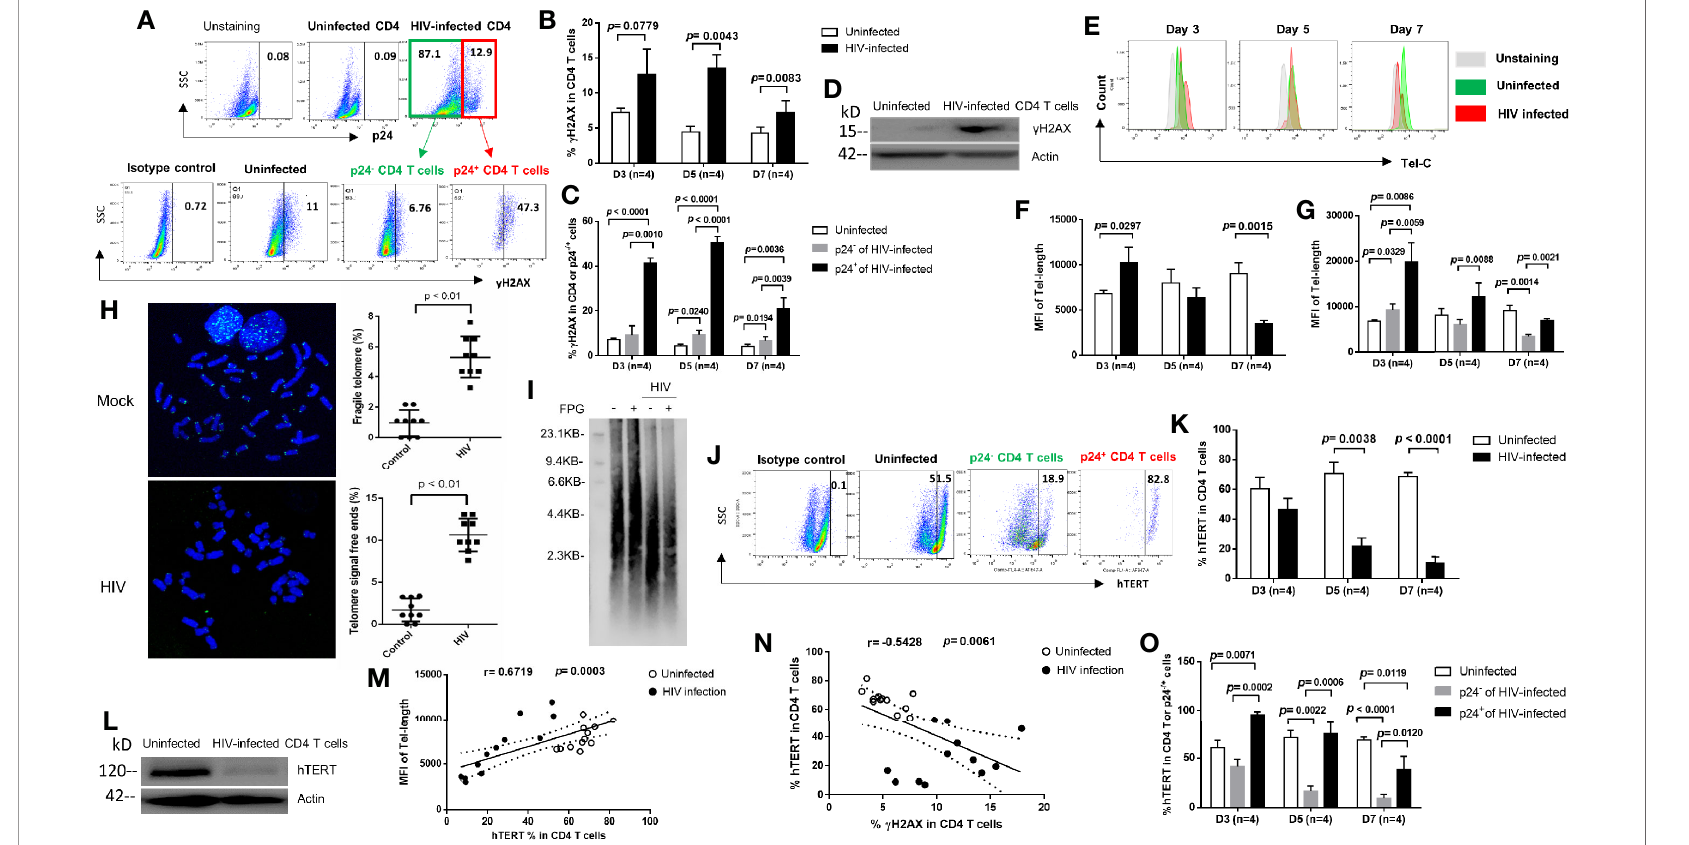
FIGURE 3 | HIV causes CD4 T cell death by inducing DNA damage and disrupting telomeres via inhibition of telomerase during early viral infection. (A) Representative dot plots and gating strategy of g H2AX levels in p24 + and p24 - CD4 T cells with HIV infection at day 7. Isotype staining and uninfected CD4 T cells serve as negative controls for fl ow cytometry. (B, C) Summary data of g H2AX % in HIV-infected (p24 + vs. p24 - ) and uninfected cells at days 3, 5, and 7. (D) Western blot analysis of g H2AX levels in HIV-infected versus uninfected CD4 T cells at day 5. (E – G) Representative overlaid histograms and summary data of the mean fl uorescence intensity (MFI) of telomere length in HIV-infected (p24 + or p24 - ) and uninfected CD4 T cells at days 3, 5, and 7, as determined by Flow-FISH. (H) Representative imaging and summary data of meta- FISH analysis of the frequencies (%) of chromatin with fragile telomeres and telomere-free ends in CD4 T cells with or without HIV infection at day 5, measured by confocal microscopy. (I) Telomere length in CD4 T cells with or without HIV infection at day 5. Telomeric DNA was treated with or without FPG and analyzed by Southern blot. (J, K, O) Representative dot plots and summary data of the human telomerase (hTERT) % in HIV-infected (p24 + or p24 - ) and uninfected CD4 T cells at days 3, 5, and 7. (L) Western blot analysis of hTERT levels in HIV-infected versus uninfected CD4 T cells at day 5. (M) Correlation analysis between hTERT expression and telomere length. (N) Correlation analysis between hTERT expression and g H2AX level in HIV-infected and uninfected